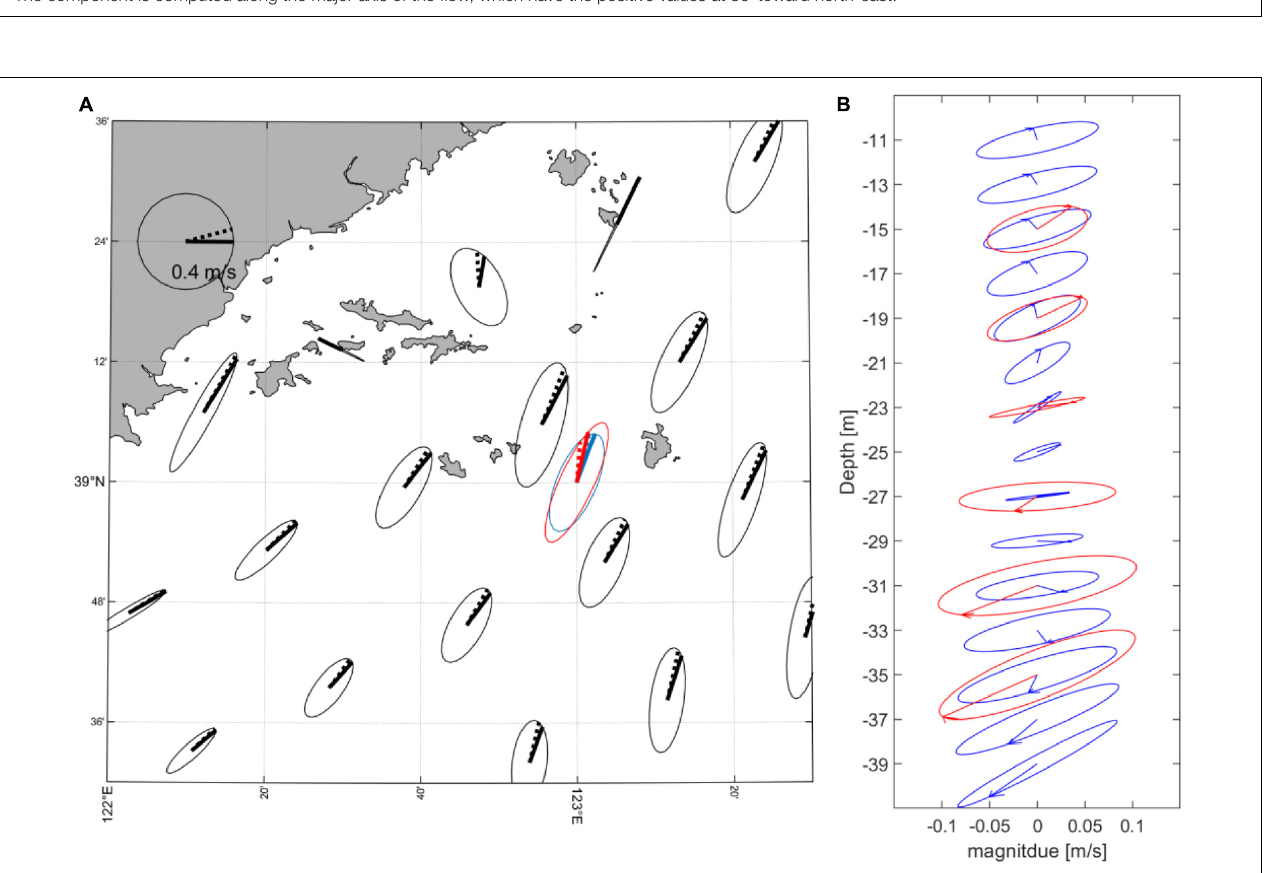
FIGURE 5 | (A) The barotropic M2 tidal ellipse derived from the model results (black), the ADCP observation (blue), and the simulation results at the mooring site (red) for 2017. (B) The vertical baroclinic M2 tidal ellipse derived from ADCP mooring results (blue) and the simulated ellipses (red) at given depths.